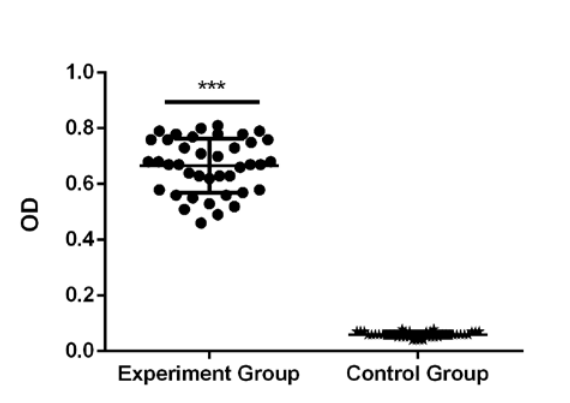
Figure 1: The absorbance of serum HBHA antibody in the spinal tuberculosis group and the healthy control group. The absorbance of antibodies was 0.65 ± 0.16 and 0.06 ± 0.02 in the experimental group and the control group, respectively. A t test was used for stati- stical analysis, which showed that the difference in HBHA antibody absorbance between the experimental group and the control group was statistically significant (P <